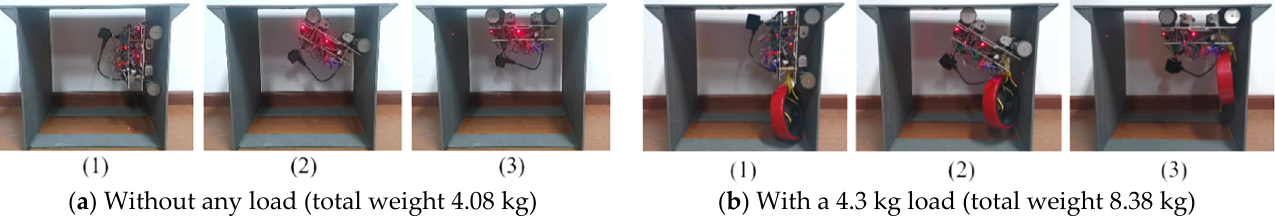
Figure 11. Experiment of the robot crossing a 90° concave corner.